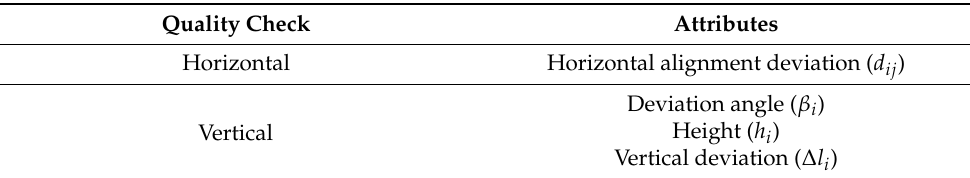
Table 3. Attributes in the proposed IQC method.